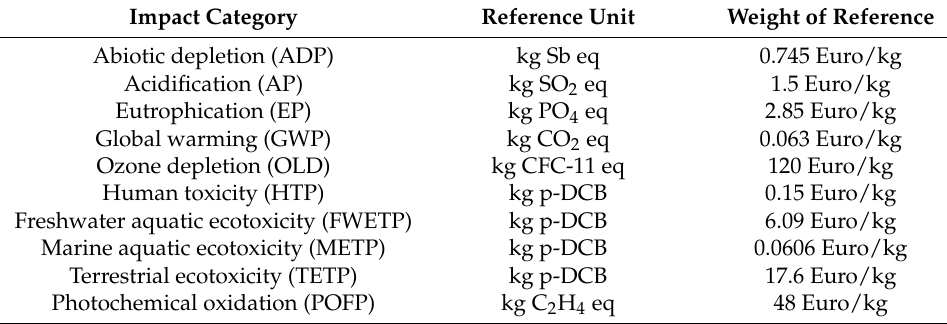
Table 8. Weighting factors of Ecotax 2002 method